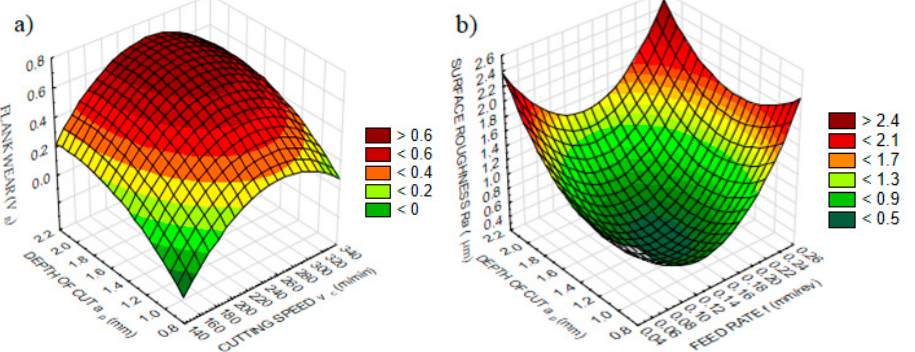
Figure 2. The variation of measured variables according to effective parameters: ( a ) flank wear and ( b ) surface roughness.